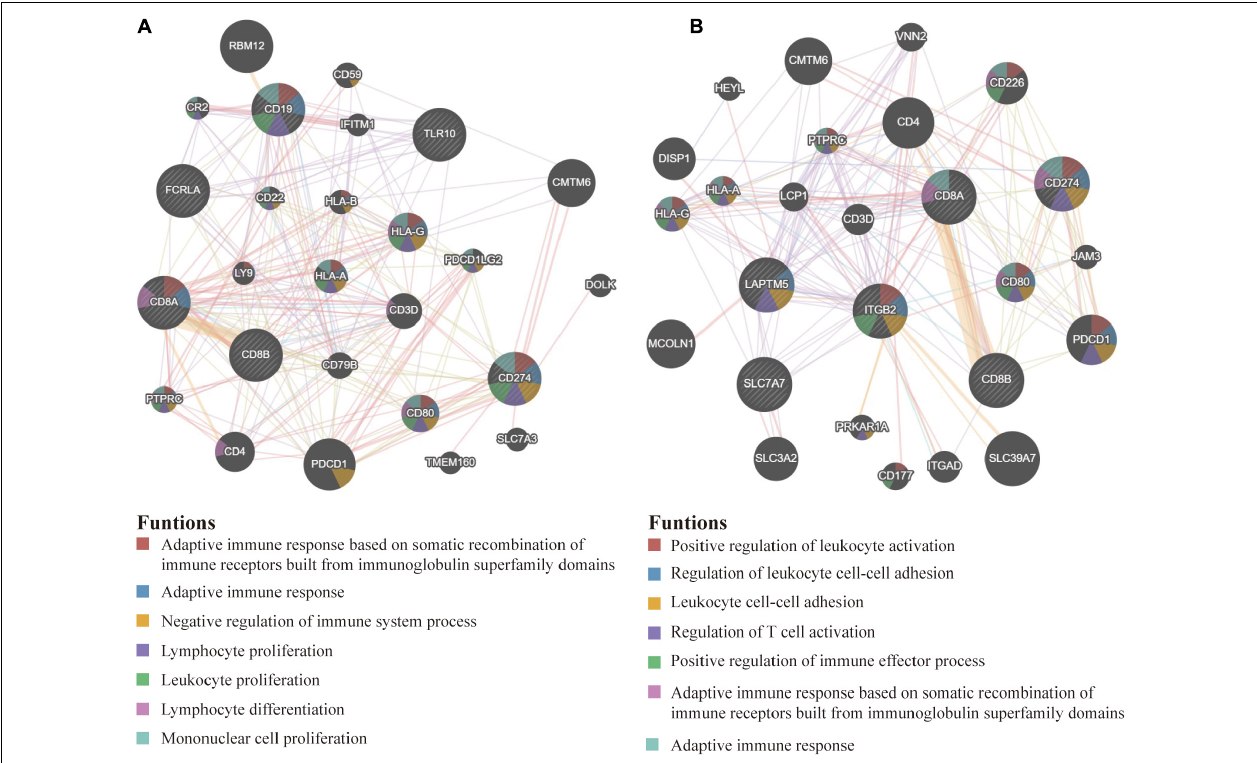
FIGURE 8 | The PPI network. (A) The most relevant genes of PD-L1, CD8A, CD8B, CD19, TLR10, and FCRLA are displayed in the PPI network. (B) The most relevant genes of PD-L1, CD8A, CD8B, ITGB2, LAPTM5, and SLC7A7 are also shown in the PPI network. Their significant enrichment results are listed below ( P <